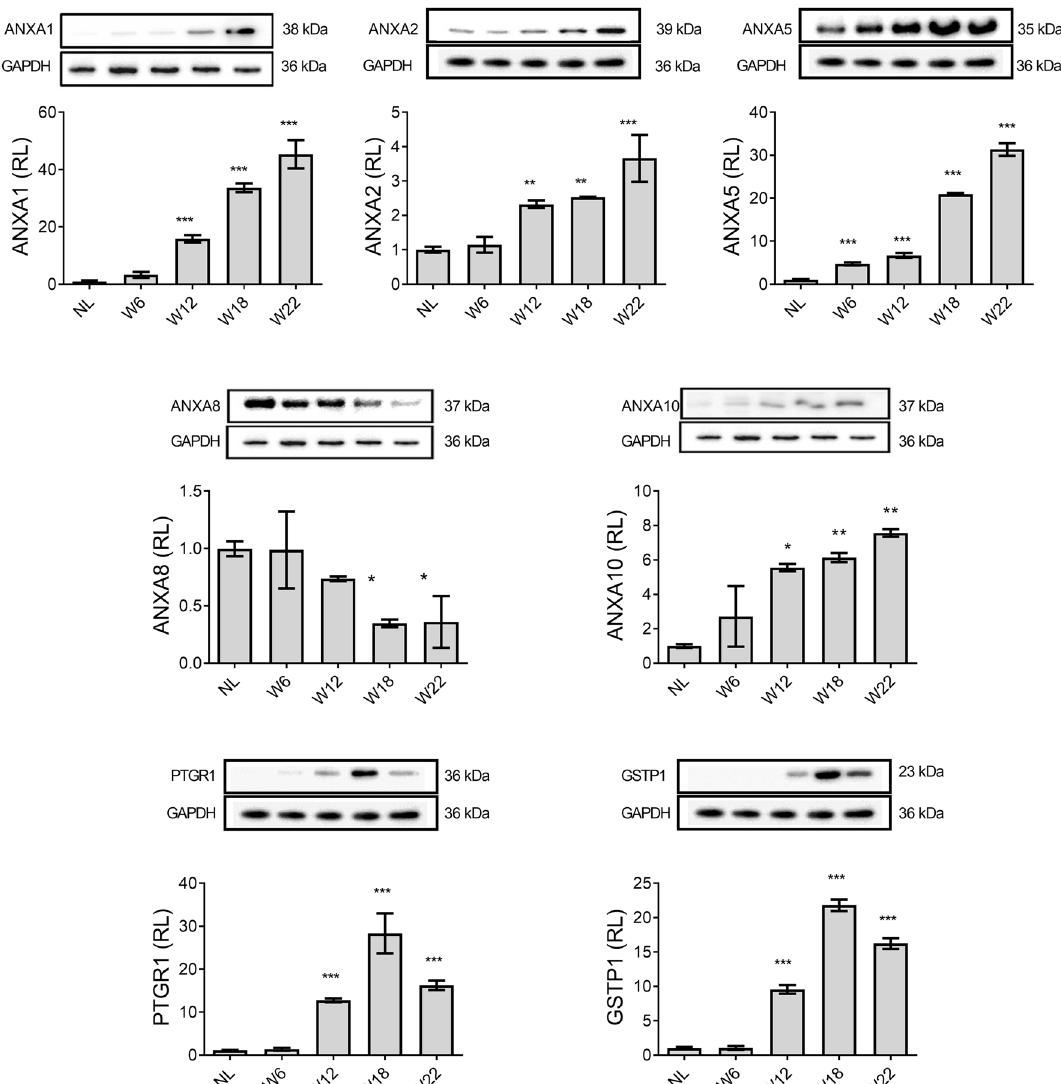
Figure 2. The protein level of annexins and well-known HCC markers. Representative images of Western blot analysis from liver tissue. Bars show the relative levels compared to the NL group and represent the mean ± SD. p values were calculated by ANOVA test. n = 5 animals/group. NL normal liver, W week. *** p < 0.001; ** p < 0.01; * p < 0.05. Images were captured with the Uvitec MINI HD6 photo-documentation system. Original blots of figure are presented in Supplementary Information